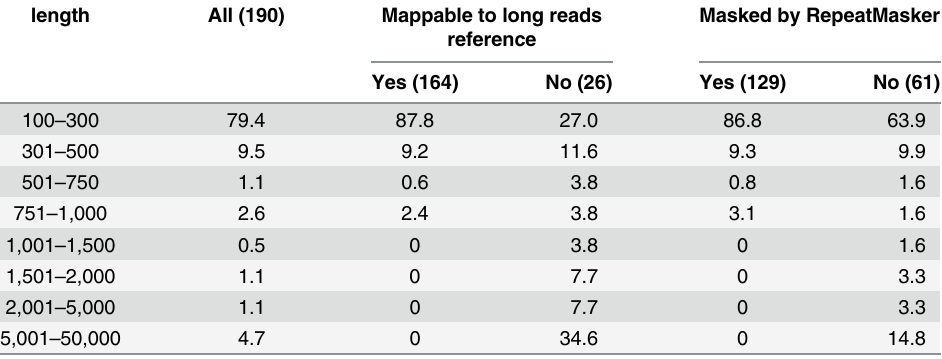
Table 5. Length distribution of the 190 potentially novel repeats. The numbers in parentheses are the numbers of repeats in each category. For each range of repeat lengths, the number is the percentage of repeats falling in the